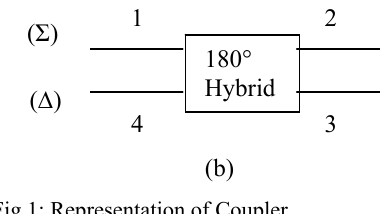
Fig 1: Representation of